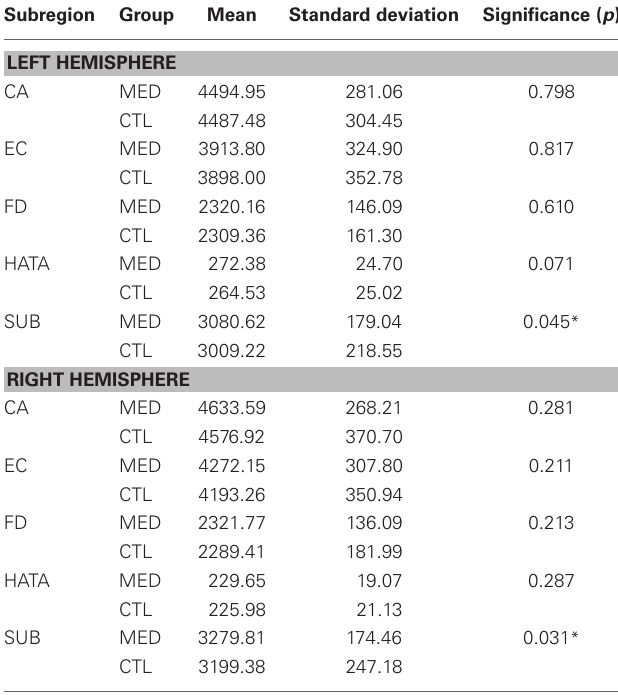
Table 1 | Volumetric GM estimates (in mm 3